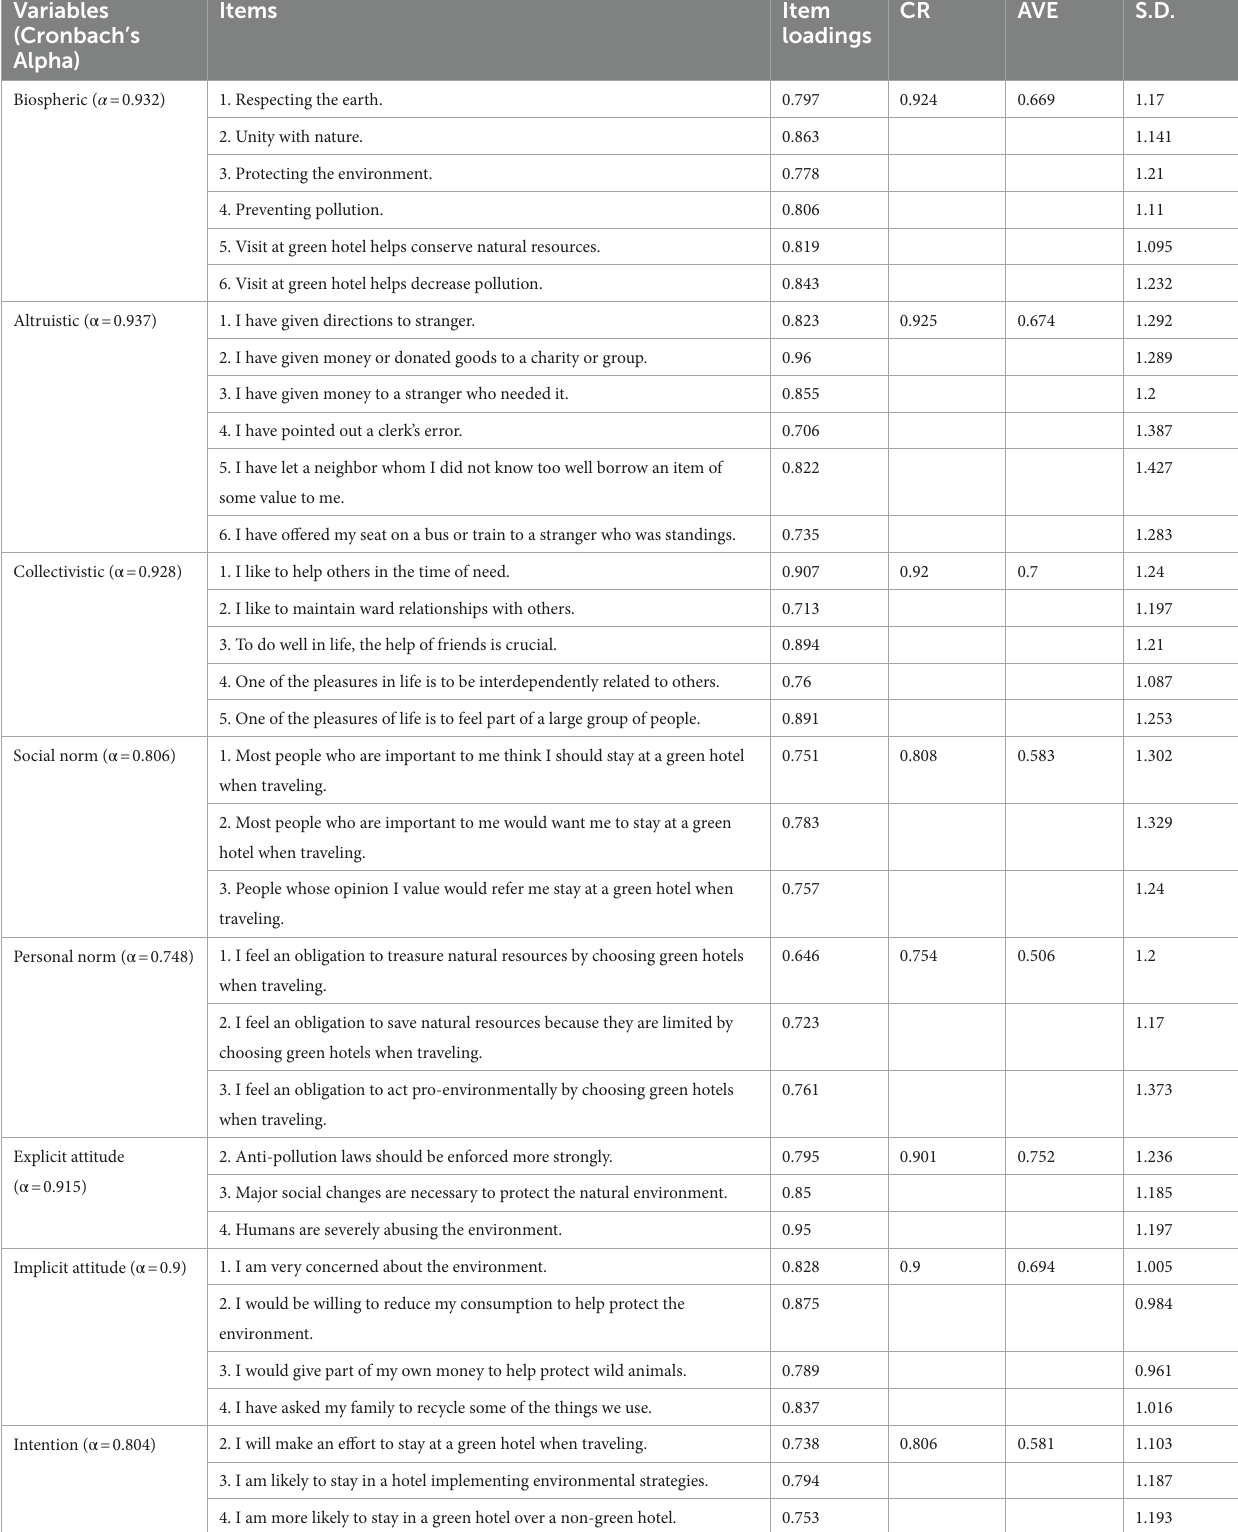
TABLE 2 Reliability and convergent validity of measurement